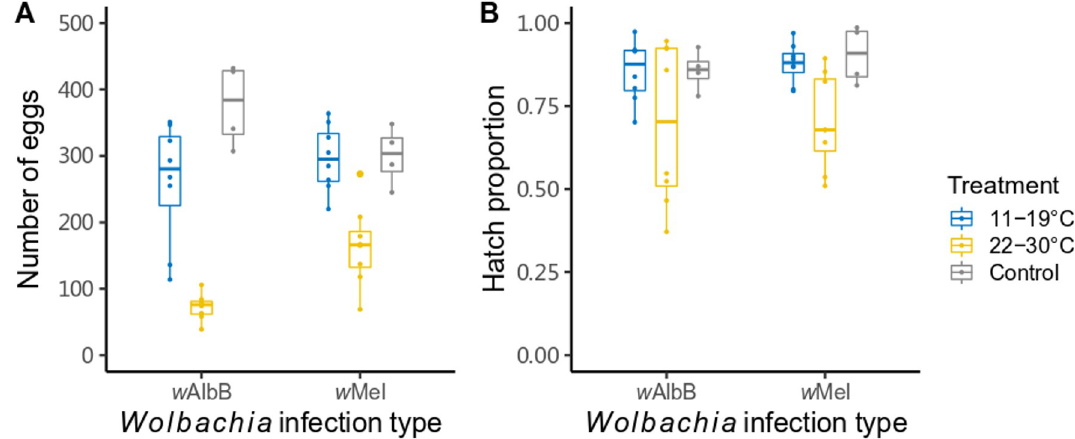
Fig 3. Reduced fertility of Wolbachia -infected warm-stored females crossed to Wolbachia -infected unstored males. (A) Number of eggs laid by females and (B) their hatch proportions. Wolbachia -infected females were derived from eggs stored under 26˚C for less than three weeks (control) or a cycling temperature of 11–19˚C for 14 weeks or 22–30˚C for 11 ( w Mel-infected) or 10 ( w AlbB- infected) weeks. Each data point represents the total number of eggs laid and their hatch proportion from a replicate cage of five females and five males.